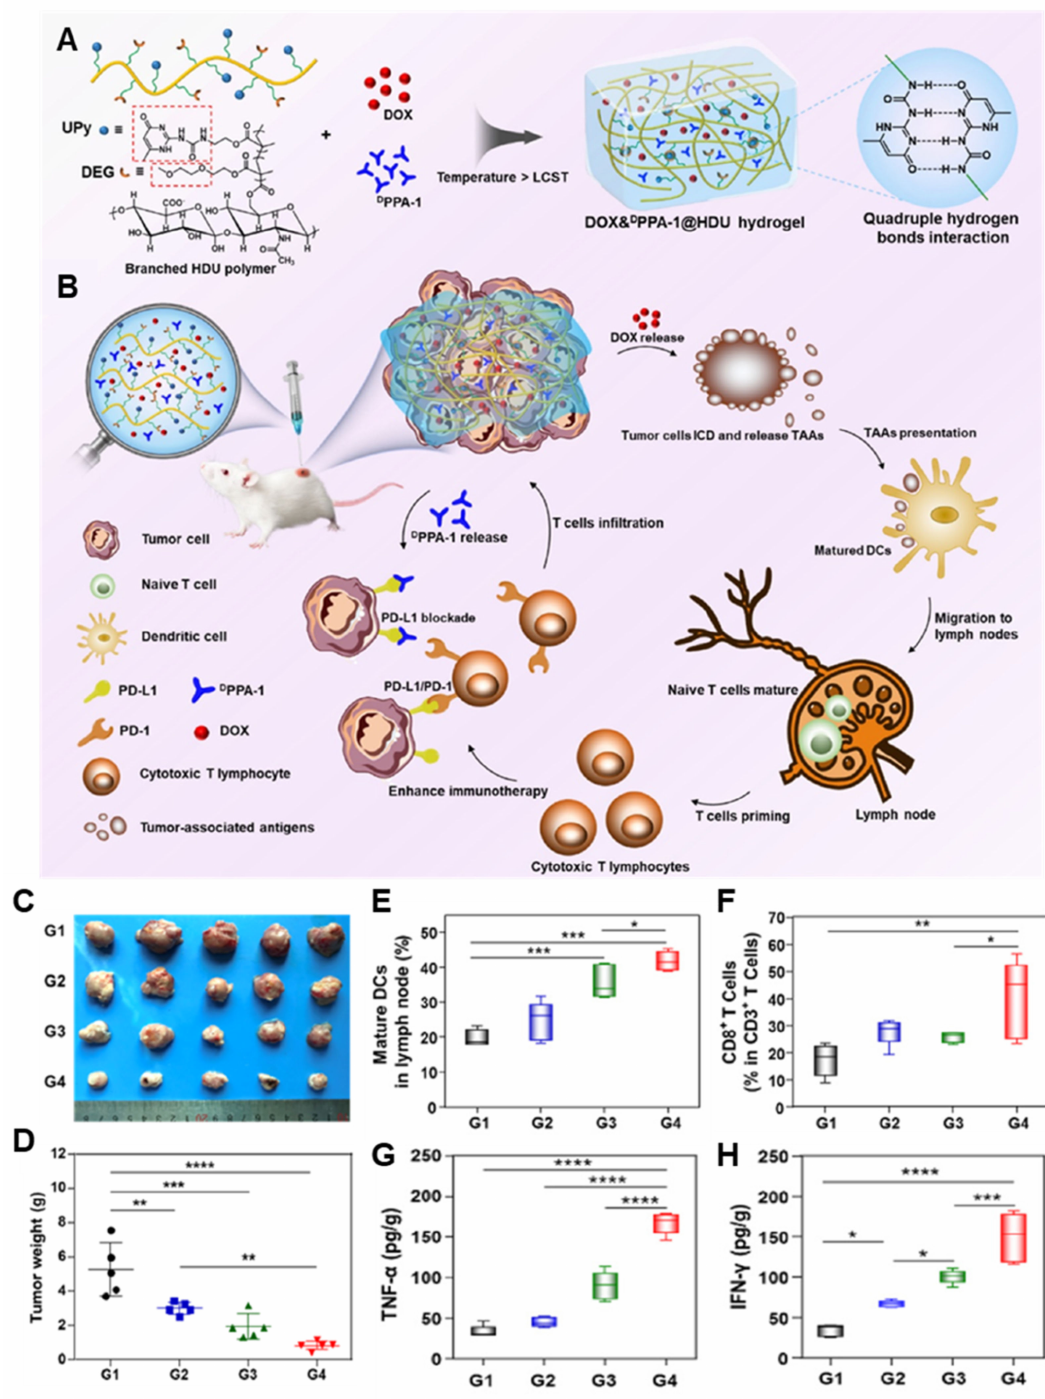
Figure 1. Injectable thermoresponsive hydrogel with D PPA-1 and DOX for combination chemoim- munotherapy. ( A ) Schematic illustration of thermoresponsive hydrogel with DOX and D PPA-1. ( B ) Schematic illustration of DOX and D PPA-1@HDU hydrogel eliciting antitumor immune responses. ( C ) Photographs of primary tumors after treatments. ( D ) Tumor weight at the end of treatment. Pop- ulations of ( E ) mature DCs in LNs and ( F ) cytotoxic T cells in tumors analyzed using flow cytometry. Quantification of secreted amounts of ( G ) TNF- α and ( H ) IFN- γ in the tumors. * p < 0.05, ** p < 0.01, *** p < 0.001, **** p < 0.0001, one-way ANOVA for indicated comparison. Figures are reproduced from reference with permission [44] from the American Chemical